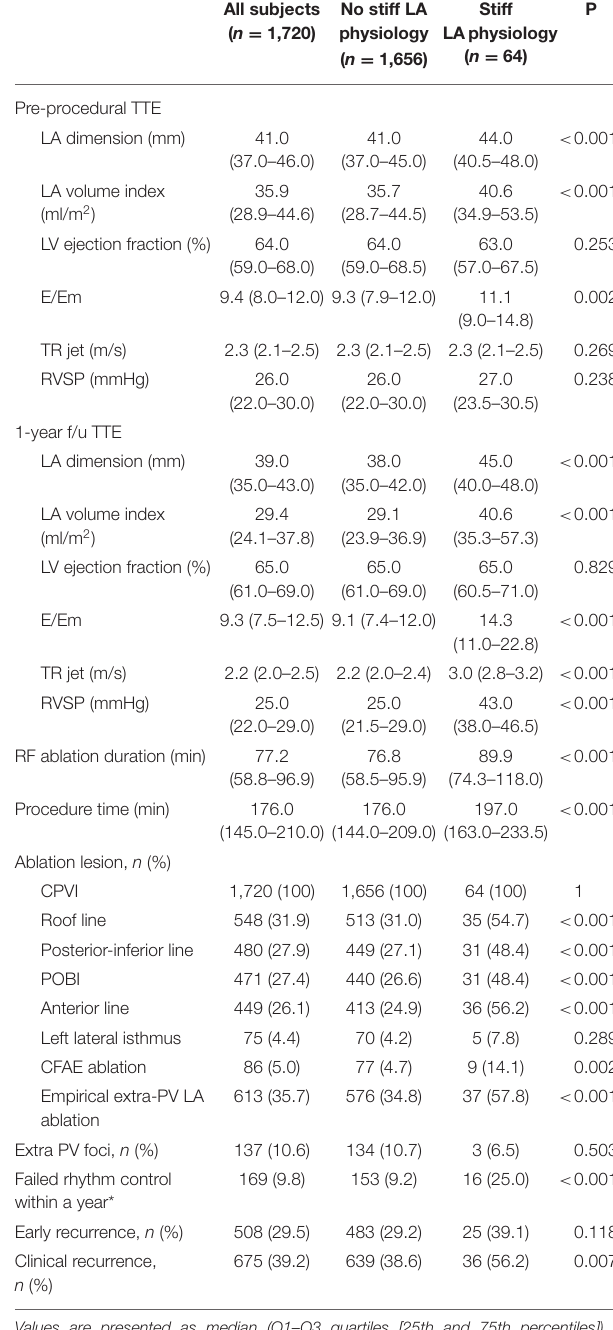
TABLE 2 | Echocardiographic and procedural characteristics according to the occurrence of stiff LA physiology. All subjects No stiff LA ( n = 1,720)